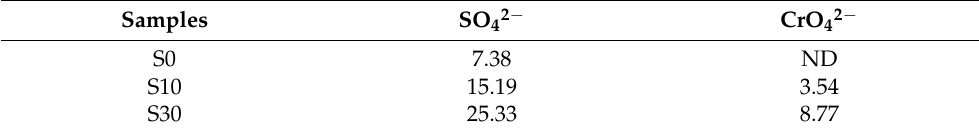
Table 4. Leaching concentrations of SO 42 − and CrO 42 − in the samples (ppm).